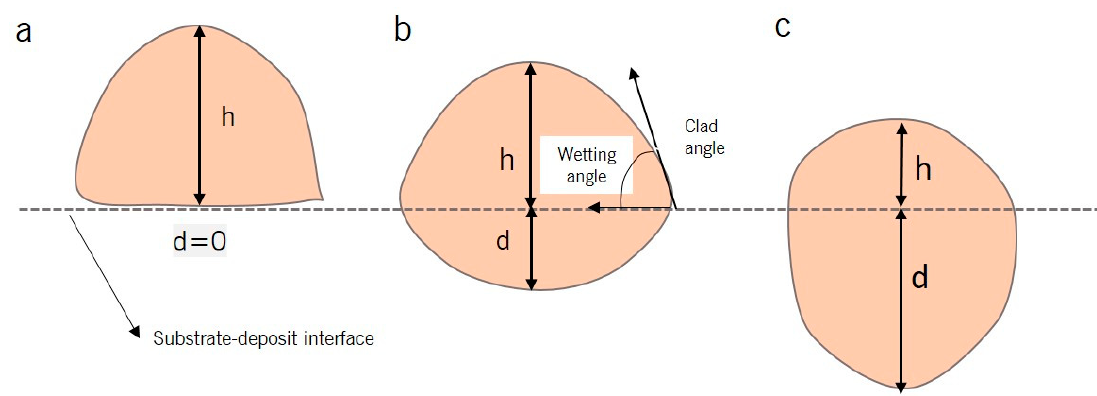
Figure 5. ( a ) Zero penetration ( d = 0) or low penetration, meaning a lack of fusion with the substrate; ( b ) optimal level of dilution (generally between 10% and 30%); ( c ) high d leads to